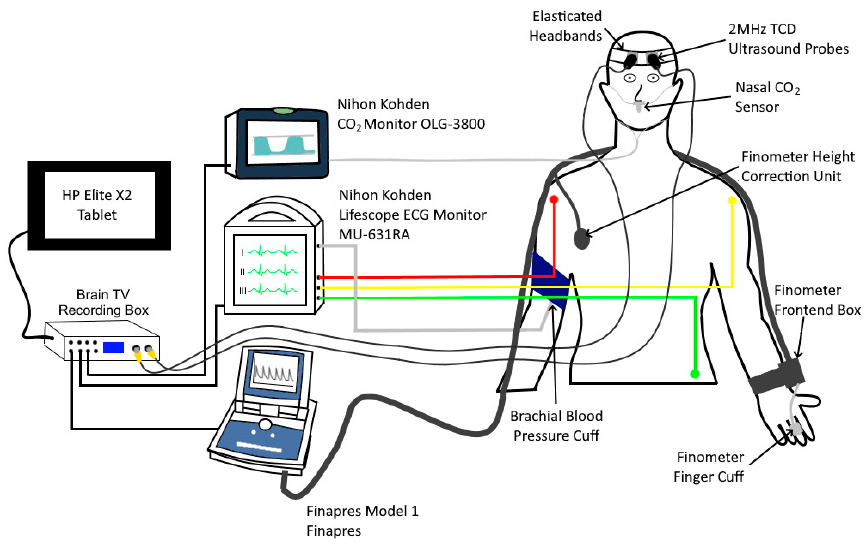
Figure 1. A schematic diagram of the experimental set-up.